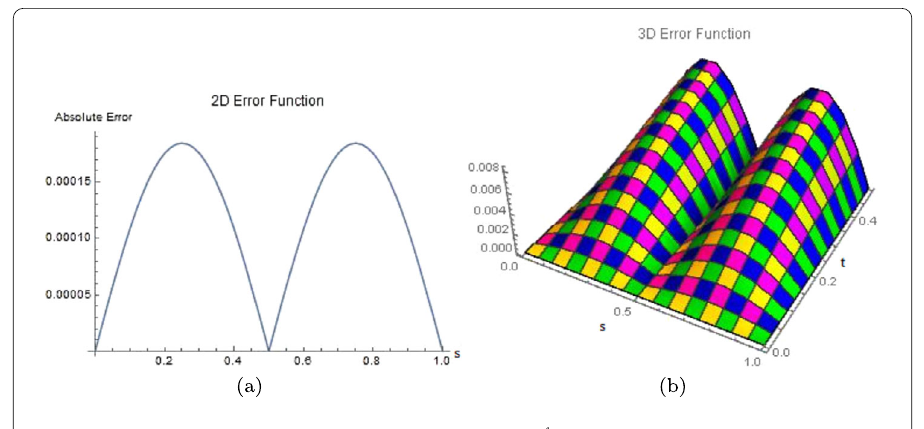
Figure 6 The exact (right) and numerical (left) solutions when τ = 0.001, h = 1